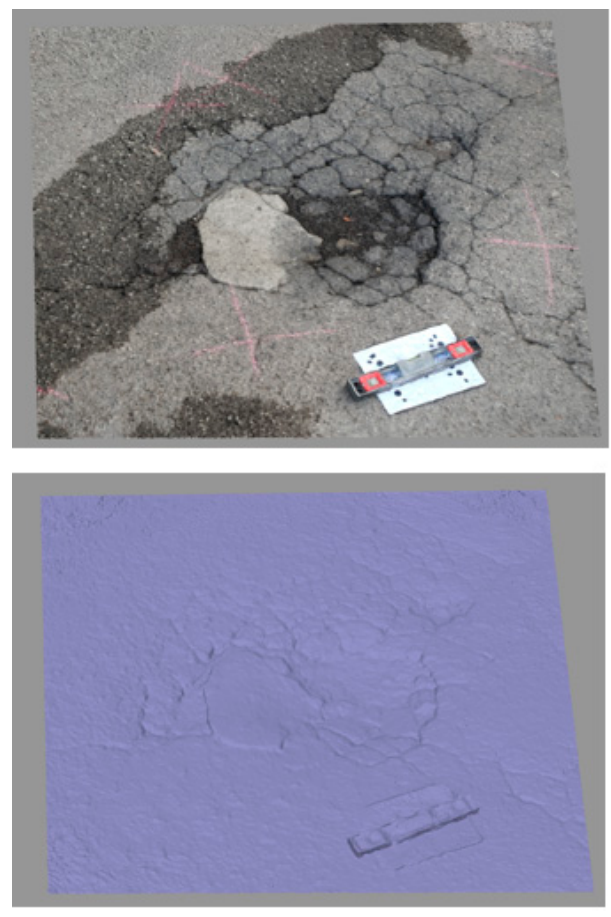
Figure 11. Model of distress 2—( top ) and dense cloud—( bottom ) produced by imagery from Samsung Galaxy s9.